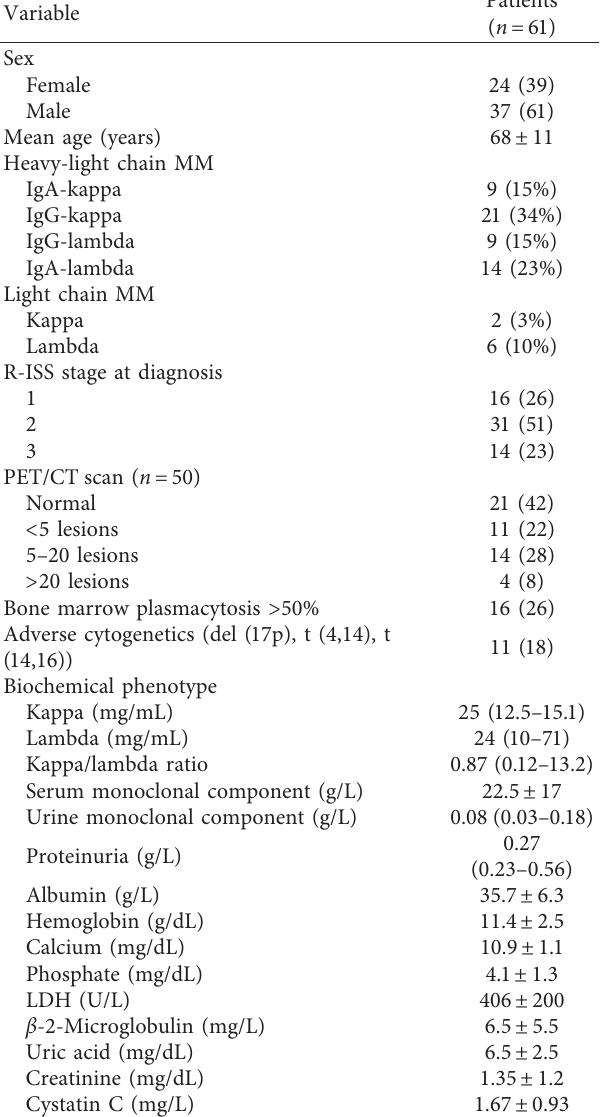
Table 1: Characteristics of the cohort of newly diagnosed and untreated multiple myeloma patients enrolled in the study.